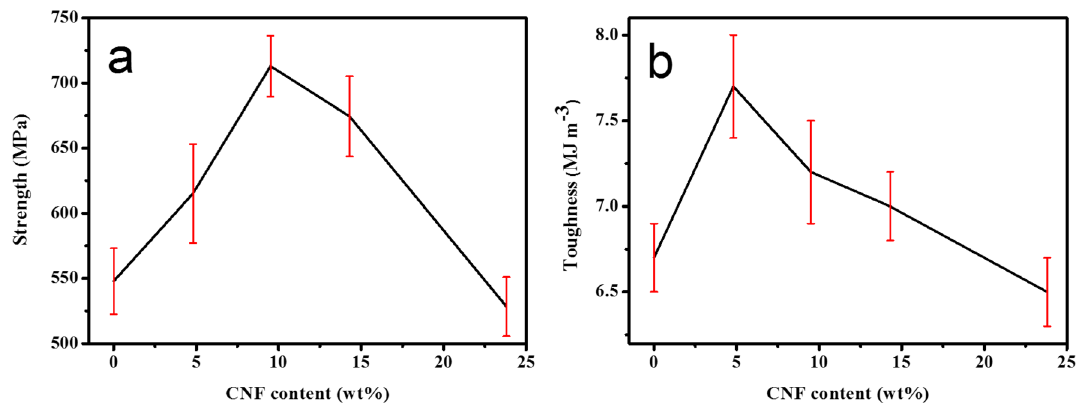
Figure 10. ( a ) Strength and ( b ) toughness of P-GCP artificial nacre with different CNF